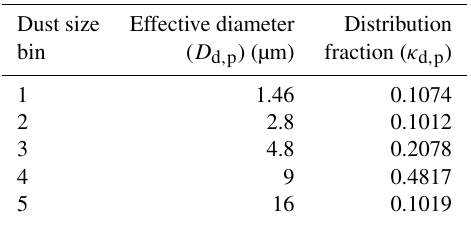
Table 2. Dust particle size bins and their associated attributes (adapted from LeGrand et al., 2019, Table 2). Particle diameters are presented here in micrometers but handled in units of centimeters within the